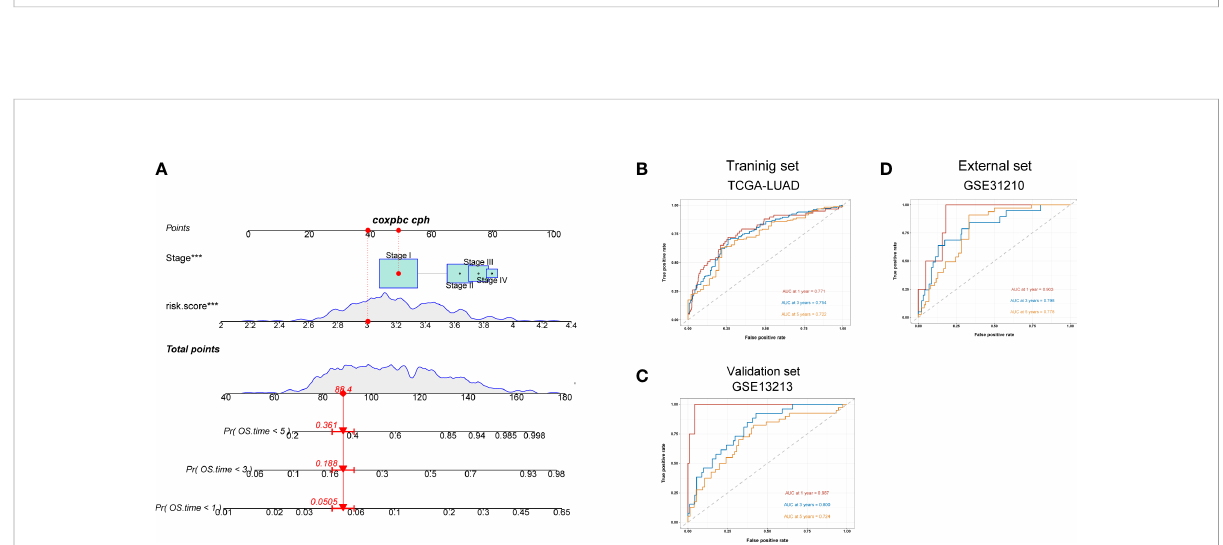
FIGURE 7 A nomogram constructed for predicting patients ’ prognosis. (A) Nomogram for predicting the 1-, 3-, and 5-year OS of lung adenocarcinoma patients in the training set. (B – D) ROC curves for predicting the 1-, 3-, and 5-year ROC curves in the training (TCGA), validation (GSE13213) cohort, and external cohort